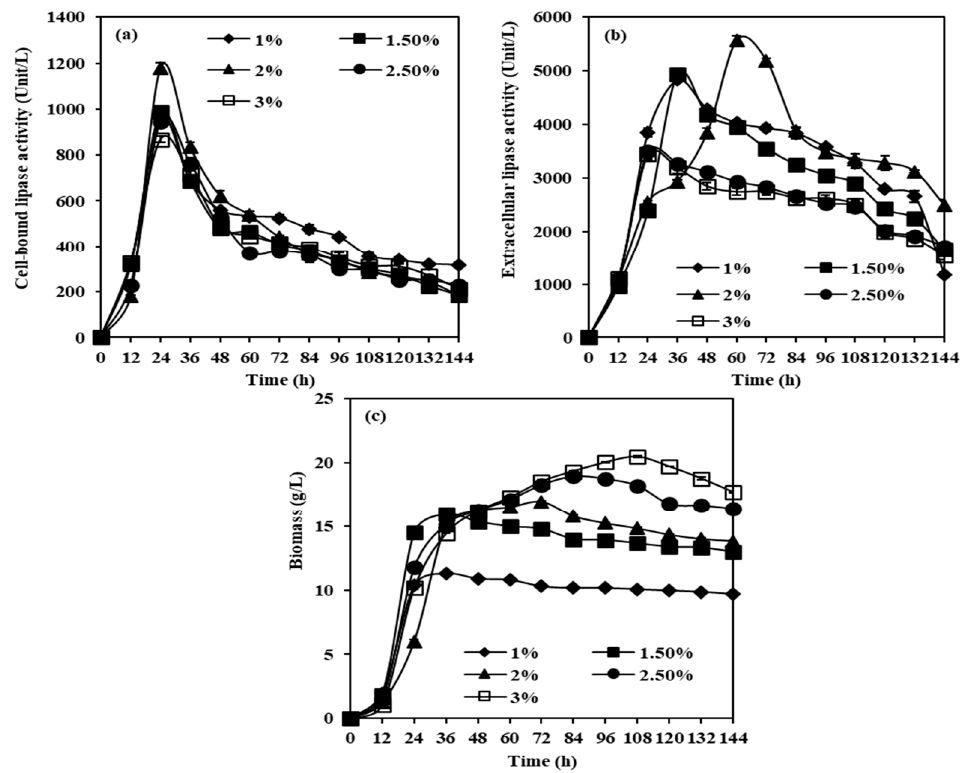
Figure 4. Effects of various concentrations of soybean oil on CBL ( a ), extracellular lipase ( b ), and biomass ( c ) production from M. spicifer SPB2 in the IMY medium containing 0.2% Gum Arabic, using an inoculum level of 1 × 10 7 cell/mL at 30 ± 2 °C under an aeration rate of 0.75 vvm and a stirring speed of 400 rpm.